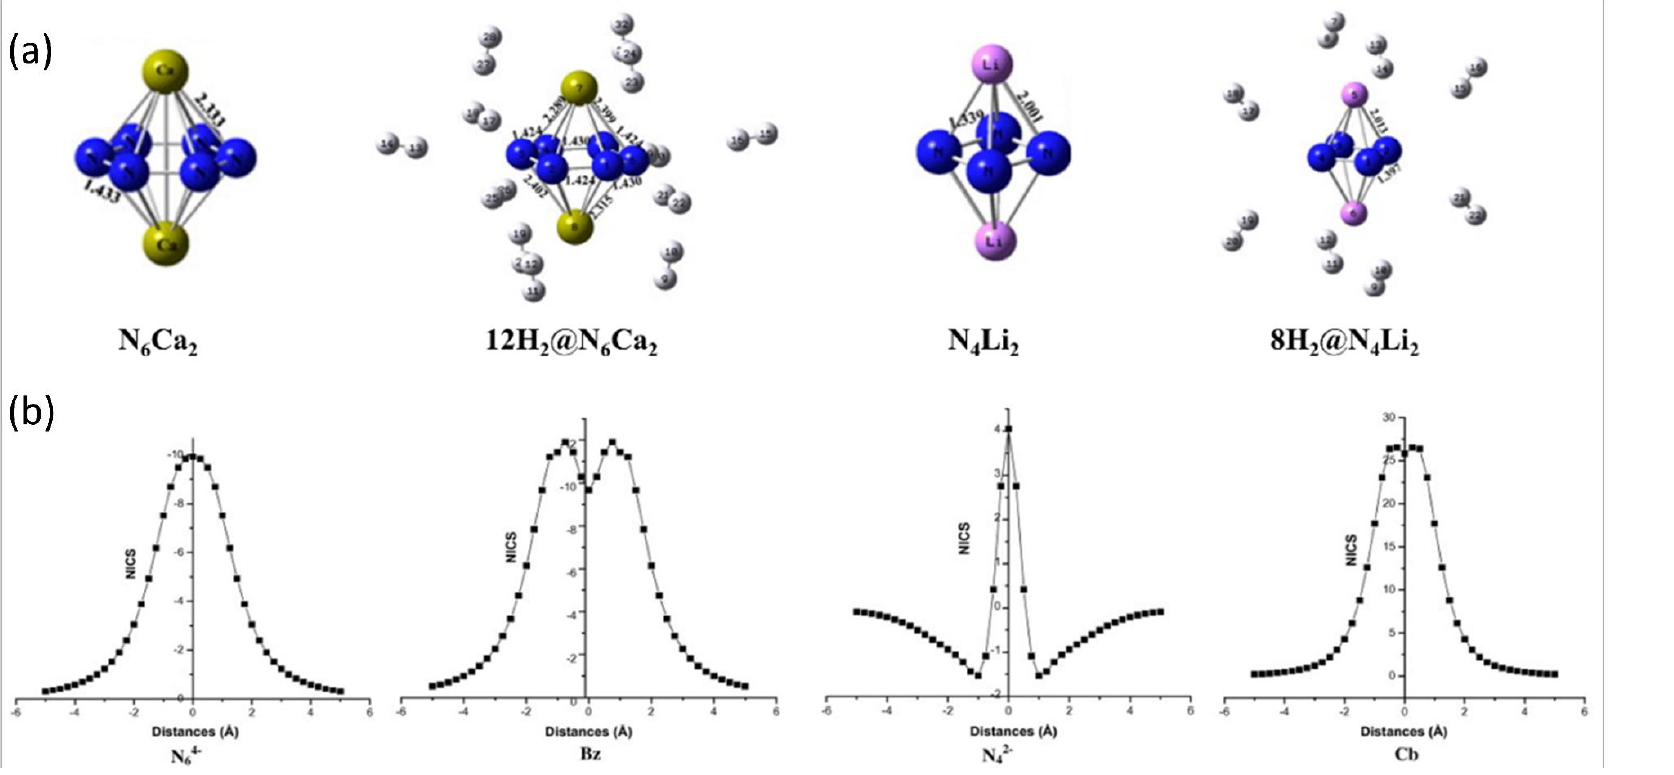
Figure 2. ( a ) Local minima forms of N 6 Ca 2 and N 4 Li 2 and their corresponding H 2 trapped equivalents. Color code: blue for N, pink for Li, green for Ca, and white for H atoms. ( b ) NICS-scan plots for N 64− , N 42− , benzene (Bz), and cyclobutadiene (Cb). This figure is reproduced from Reference [18].